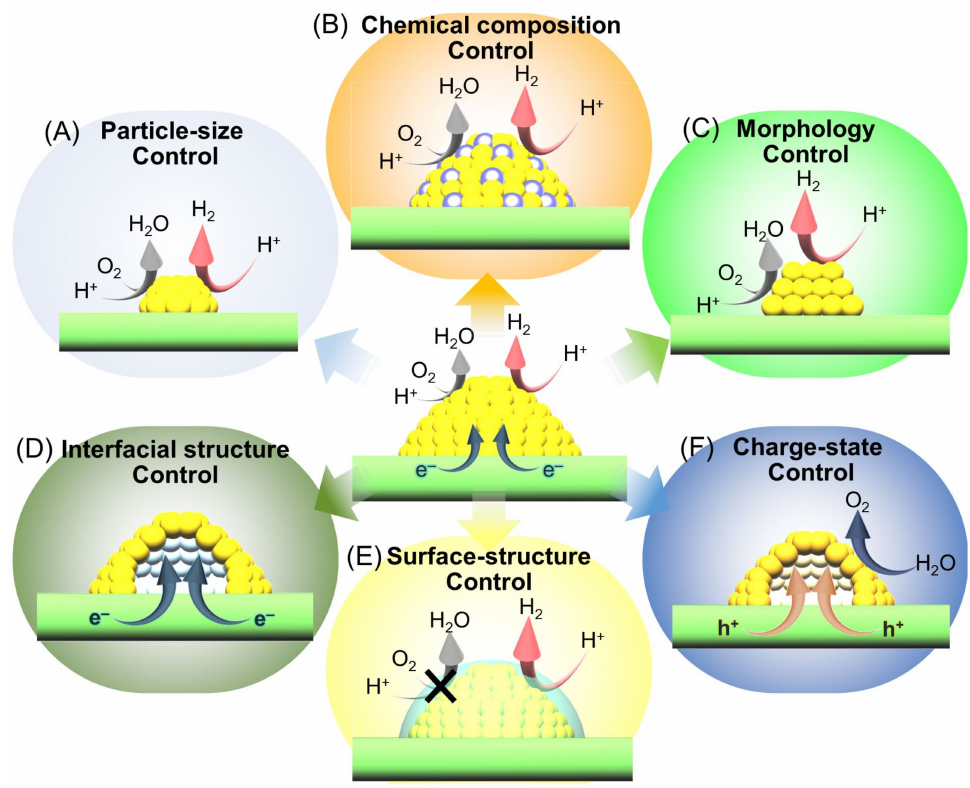
Figure 17. Schematic of photocatalyst functionalization by controlling cocatalyst properties: ( A ) par- ticle size (Section 3.1), ( B ) chemical composition (Section 3.2), ( C ) morphology (Section 3.3), ( D ) inter- facial structure (Section 3.4), ( E ) surface structure (Section 3.5), and ( F ) charge state (Section 3.6). Table 3. Effective cocatalysts, possible reaction, and efficiency of water-splitting photocatalysts (Vis-light-driven or UV-light-driven) introduced in Section 3. Possible Photocatalyst Efficiency c Reaction b